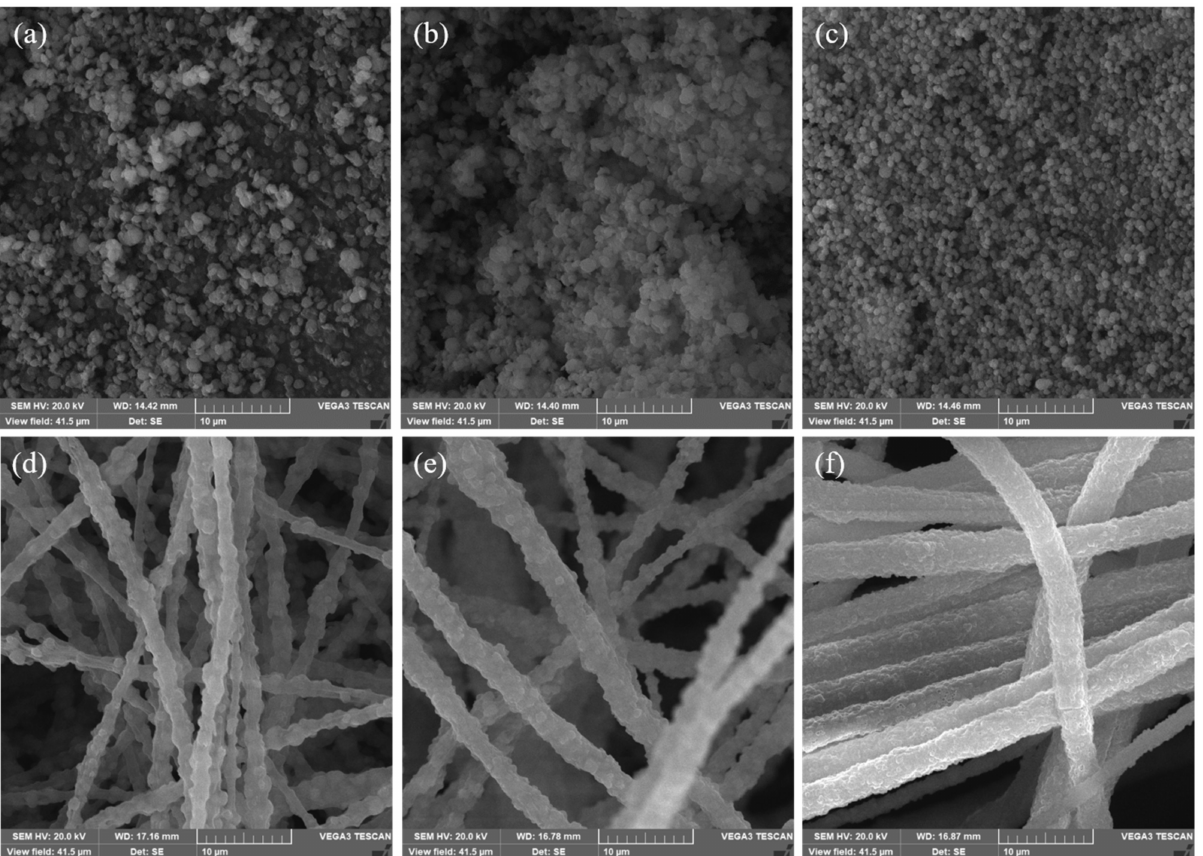
Figure 1. The SEM images of the prepared nickel-cobalt zeolitic imidazolate frameworks (Ni x Co y -ZIFs) crystals and Ni x Co y -ZIFs/polyacrylonitrile (PAN) nanofibers at various molar